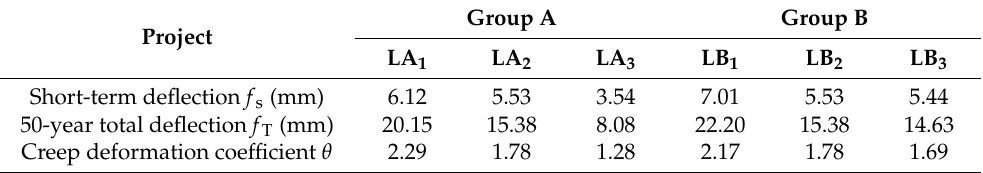
Table 6. Creep deformation coefficient for 50